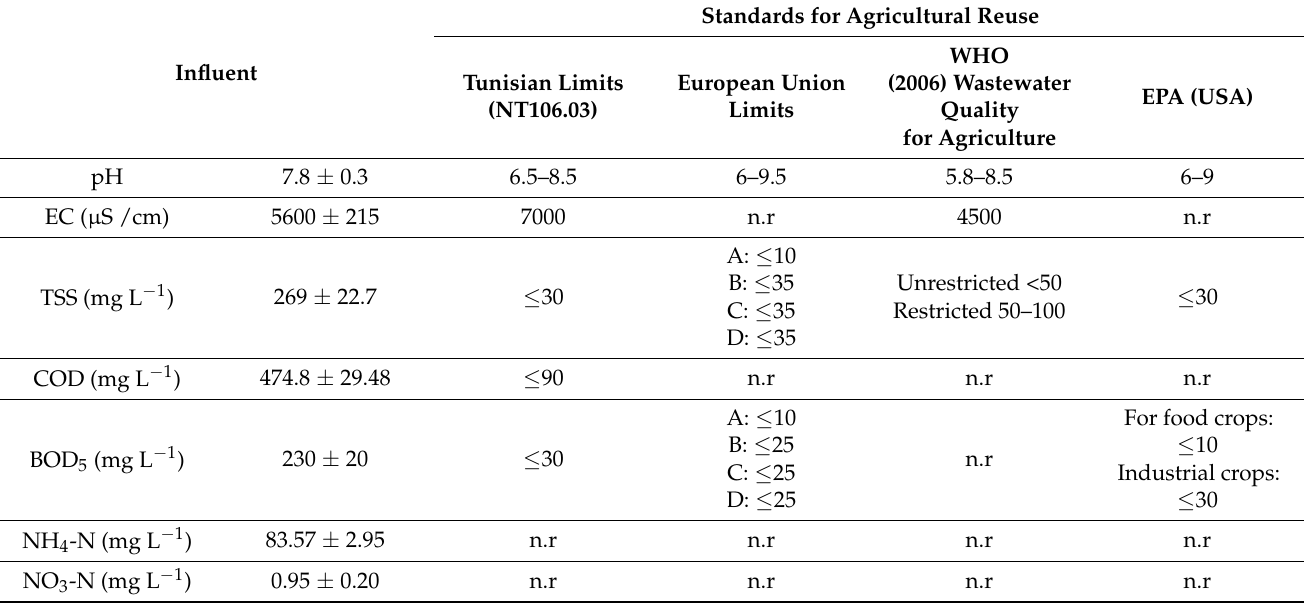
Table 1. Influent characteristics and water quality standards for wastewater reuse in agriculture. [42–44]. Standards for Agricultural